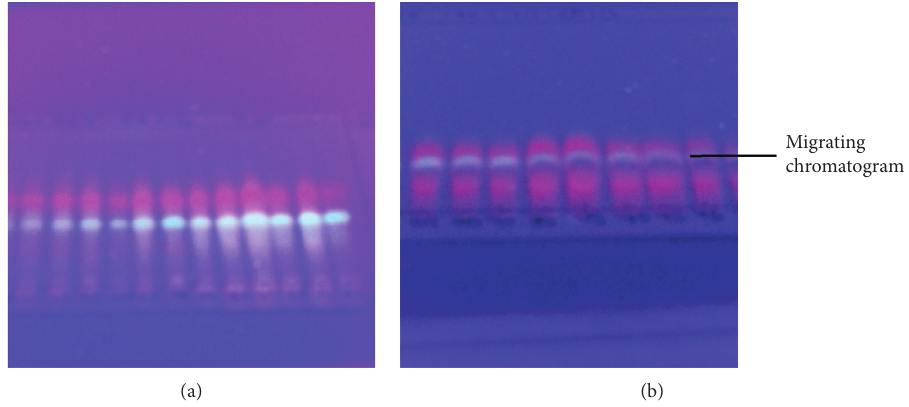
Figure 4: TCL chromatogram showing similar fractions constituting pool 7 (a) and pool 10 (b).